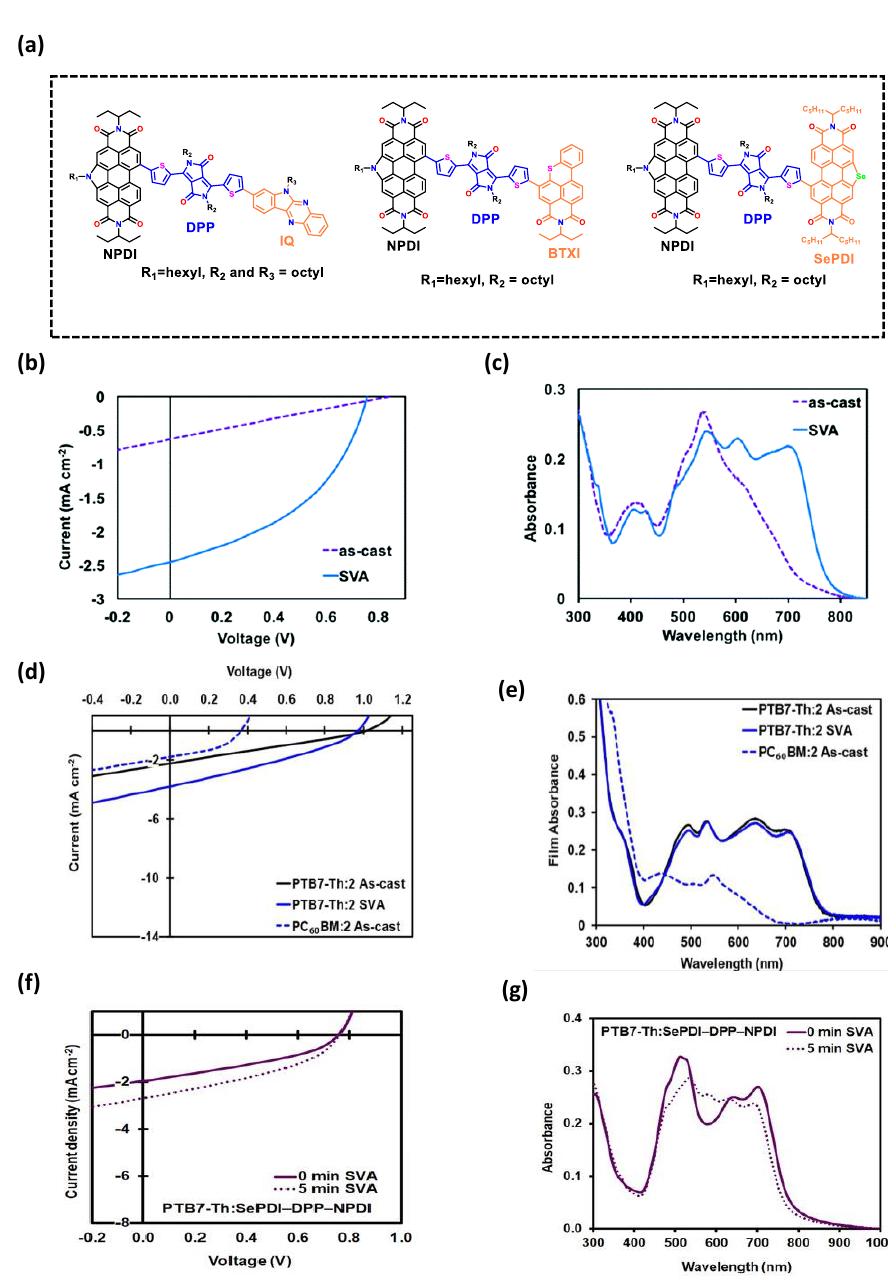
Figure 16. ( a ) Chemical structures of asymmetric PDI derivatives, ( b ) device J–V curves, and ( c ) UV–Vis absorption spectra of OPV devices based on a blend of P3HT:PDI-DPP-IQ [82]. ( d ) Device J–V curves ( e ) and UV–Vis absorption spectra of OPV devices based on a blend